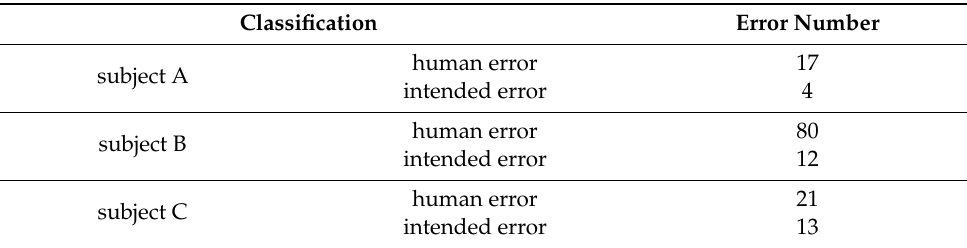
Table 8. Error number of each subject.